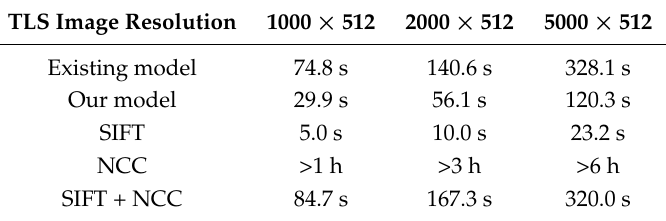
Table 5. Time performance of our model and the existing model of space